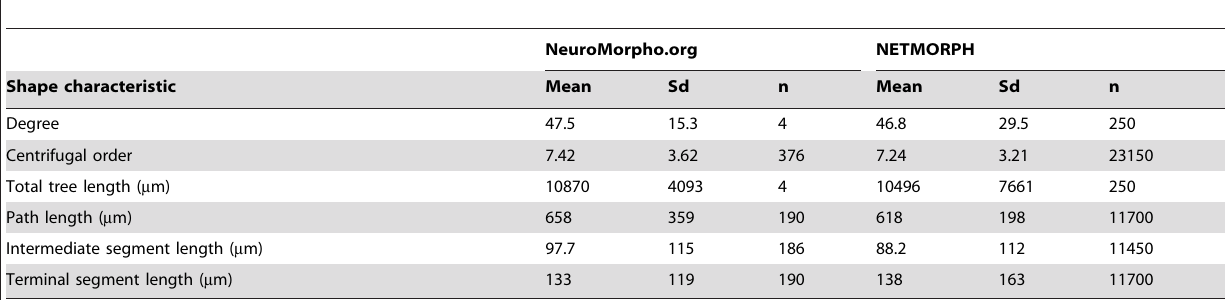
Table 2. Axonal shape characteristics of NETMORPH-generated neurons and L2/3 pyramidal neurons from the NeuroMorpho.org database.